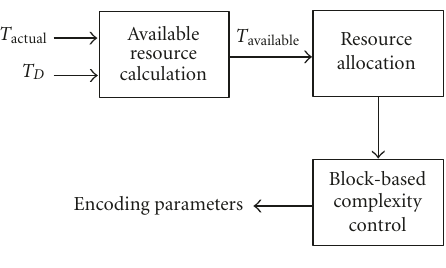
Figure 2: Control component block diagram.